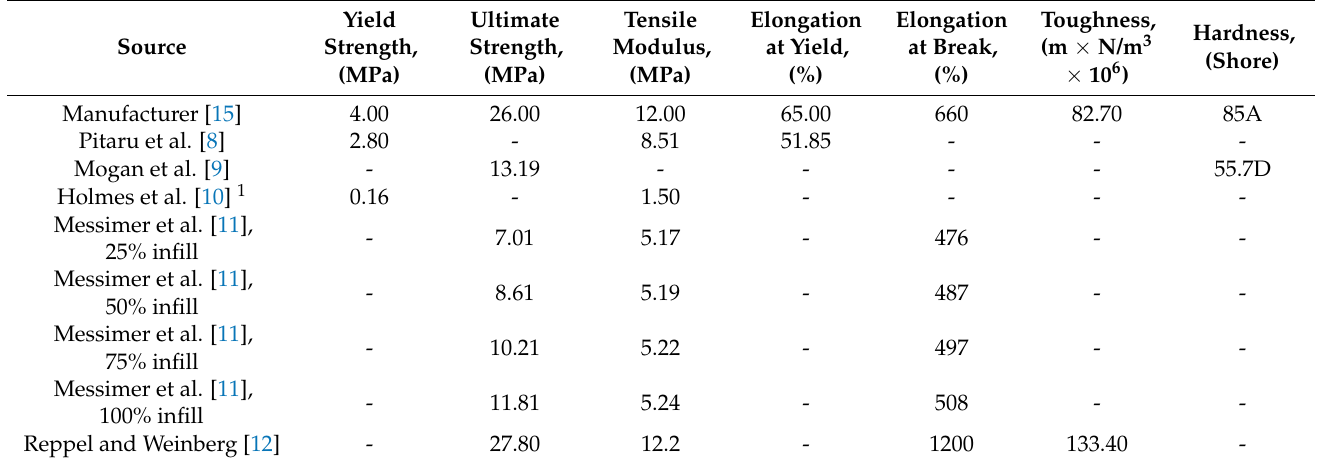
Table 1. NinjaFlex mechanical characteristics.